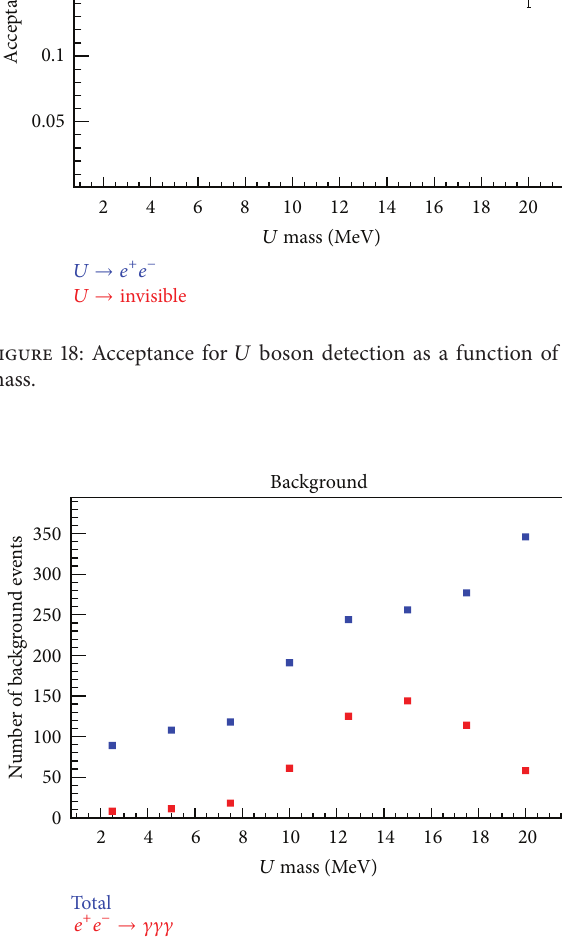
Figure 19: Background contribution as a function of the 𝑈 boson mass.